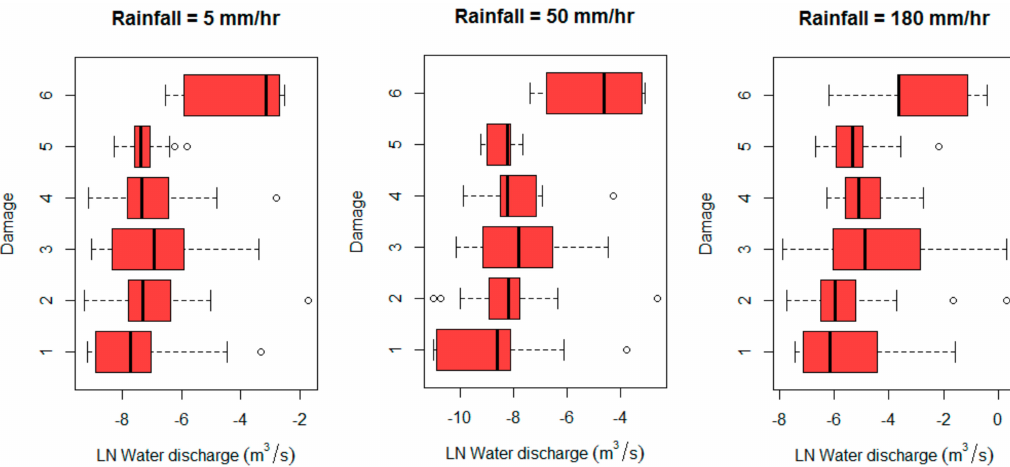
Figure 13. Box plots comparing water discharge and wall damage (using the subjective damage classification scale) for the three precipitation scenarios—Boxplot: Box = 1.5 × IQR, Q1, Q2, Q3; Whiskers = Min and